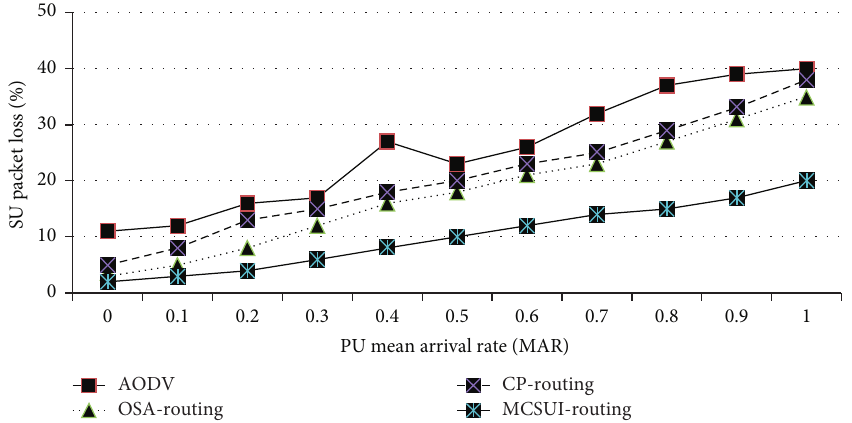
Figure 16: Packet loss of SU at PU’s sd of MAR � 0.4 (user/ms).